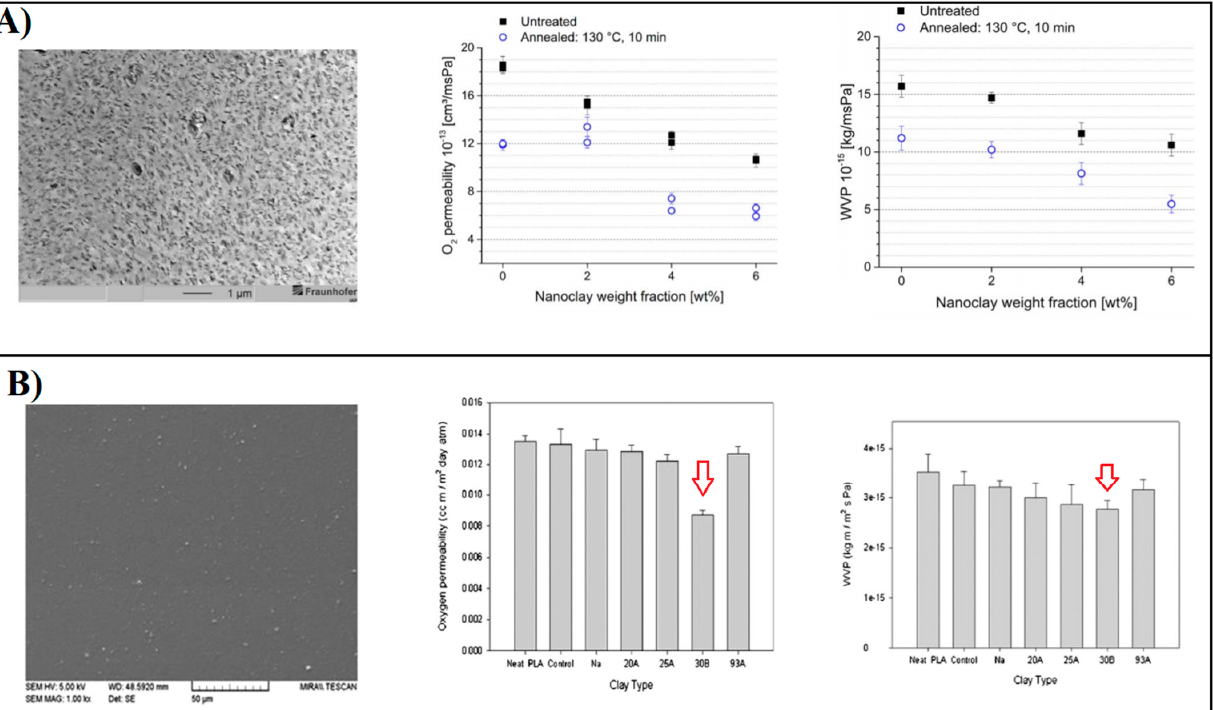
Figure 13. From left to right: ( A ) TEM image of PLA based nanocomposite films containing 6 wt% CH 30B along with oxygen and WVP values of untreated nanocomposites and annealed at 130 °C for 10 min as a function of nanoclay content. Adapted from [231] with permission of Wiley Periodicals. Copyright © 2016. ( B ) TEM and SEM images of PLA-CH 30B nanocomposites along with the relative oxygen permeability of nanocomposites with different volume fraction of clays (CNa:CH Na + , CRDP:Fyrolflex, and C30B:CH 30B). Adapted from [234] with permission from Elsevier. Copyright © 2016.